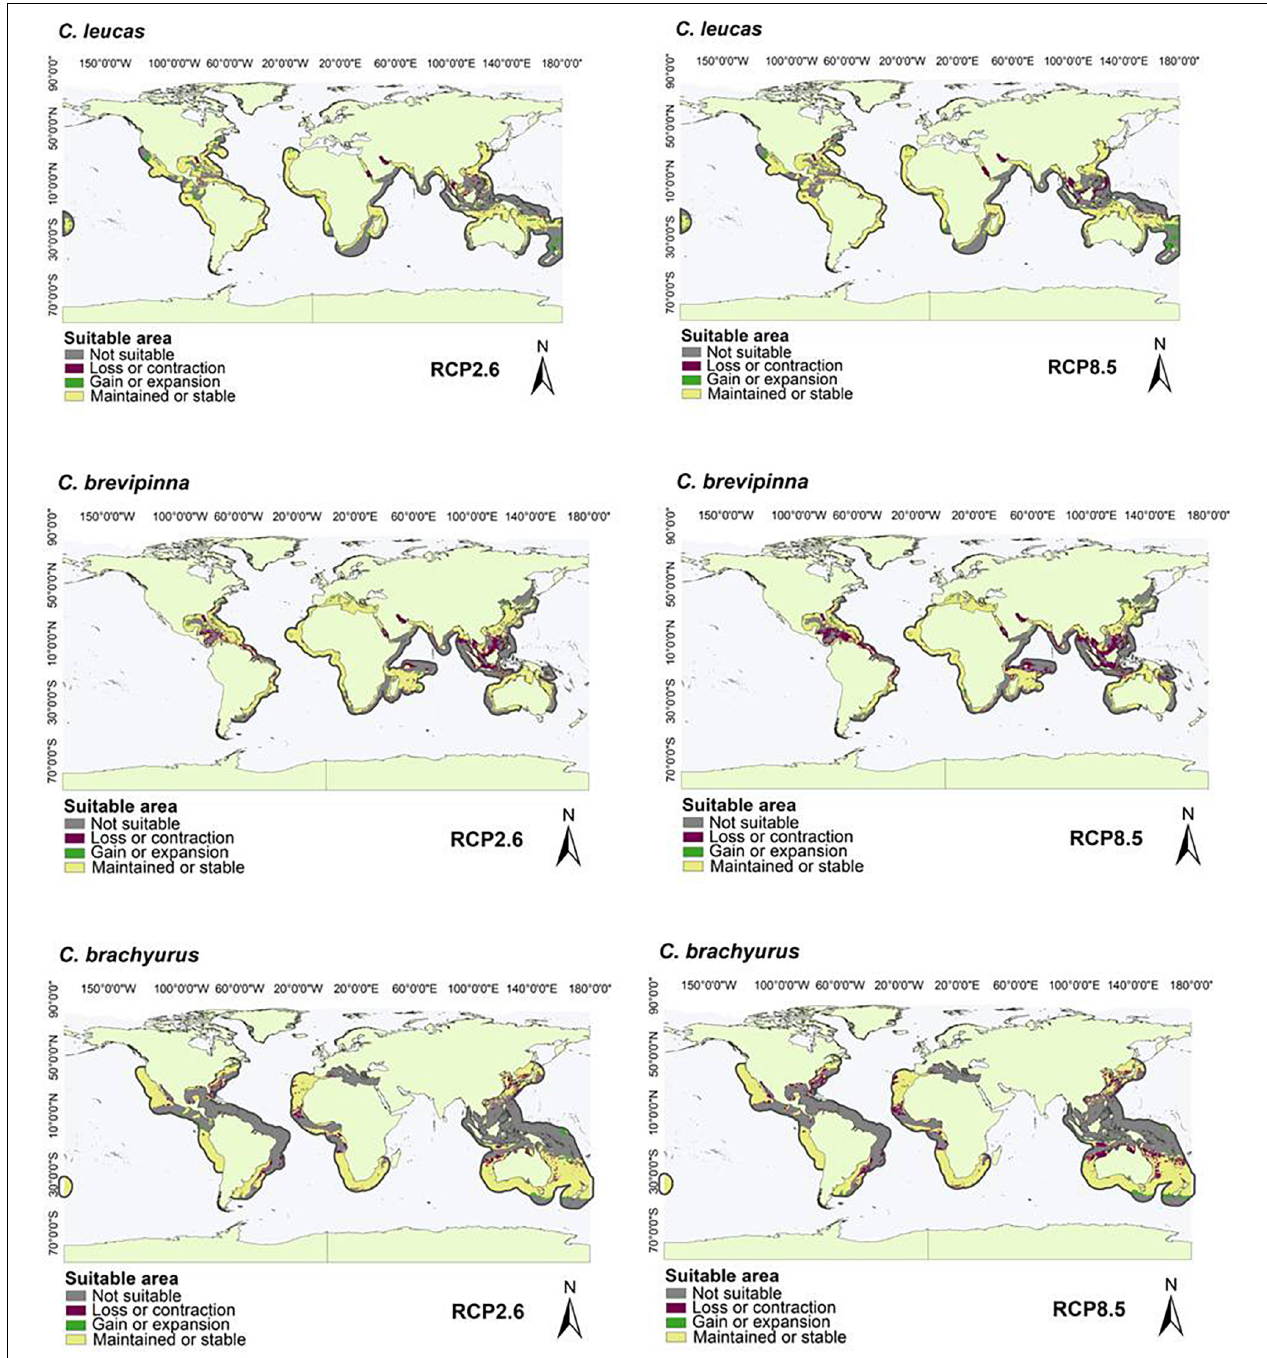
FIGURE 3 | Suitable areas maintained, gained, and lost by the year 2050 under low (RCP2.6) and high (RCP8.5) greenhouse gas emission scenarios in species with an M area in the Mediterranean Sea and some Oceans (Atlantic, Pacific, and Indian): Carcharhinus leucas, Carcharhinus brevipinna, and Carcharhinus brachyurus